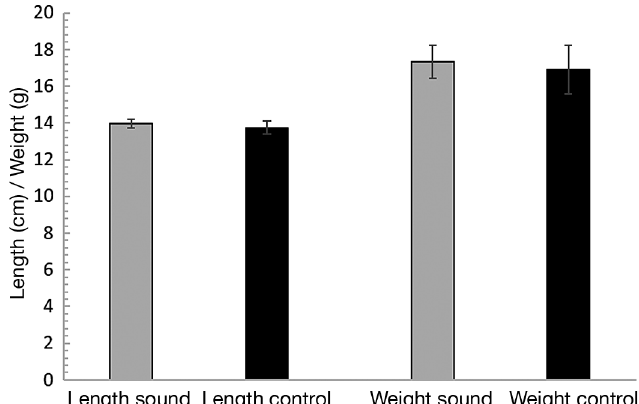
Fig. 2. Whiteleg shrimp mean length (cm) and weight (g) (tank means, N = 3 tanks per treatment) in sound and control treatments at experimental completion after 8 wk. Error bars = 1